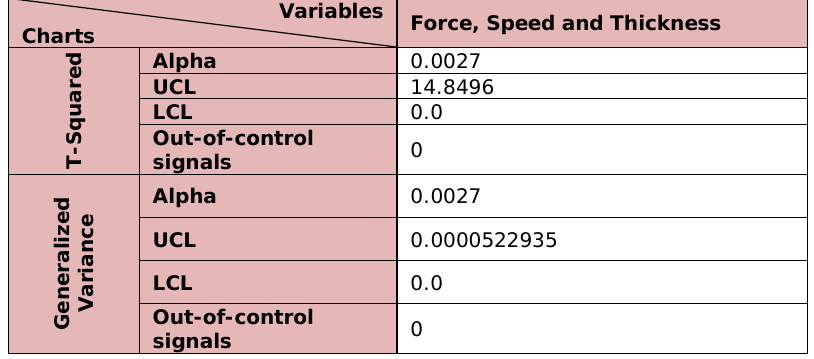
Table 10. “T 2 and generalized variance charts parameters for regressed data”.